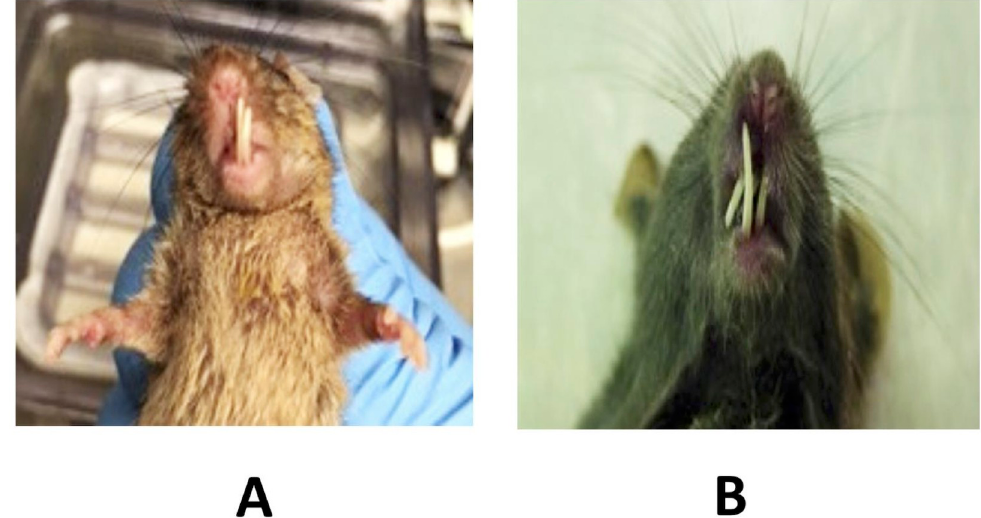
Fig 1. Typical examples of jaw malocclusion. A, Whole-mouse photograph showing the dysmorphic appearance of the incisors, as well as associated rapid malnutrition due to feeding difficulties. B, Detailed photo of incisor overgrowth defect underlying malocclusion and feeding